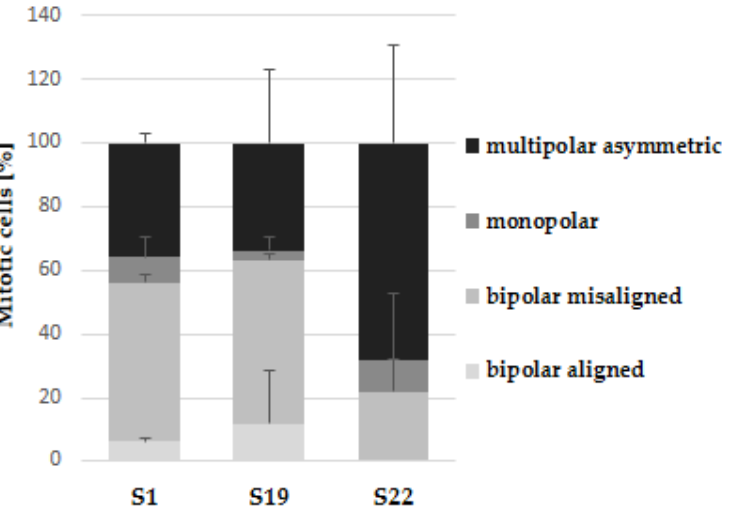
Figure 4. Representative confocal microscopy images of A375 cells after 6 h incubation with me- dium and 0.2% DMSO ( A ), compound S1 ( B ), S19 ( C ), S22 ( D ) at concentration of 10 µM, with stained α-tubulin (green) and chromosomes (blue); magnification ×20 plus zoom ×3 during acqui- sition.